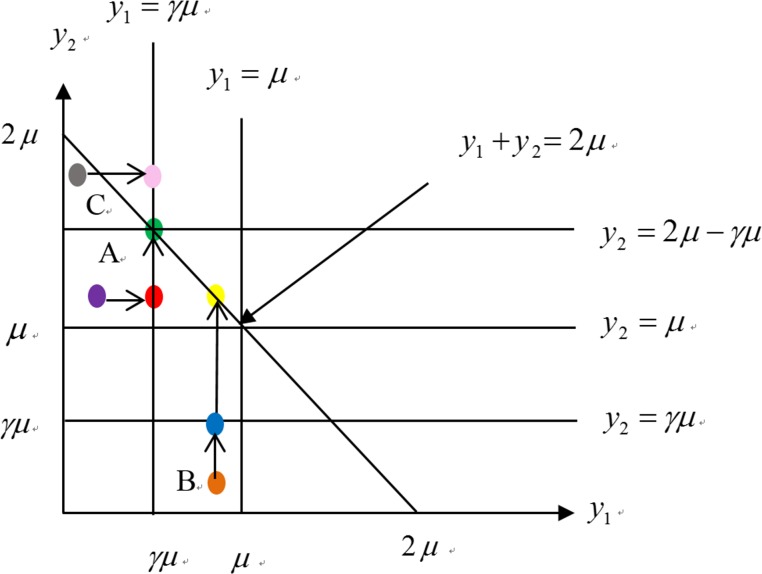
Illustration of the payment structures for a two-year YP.